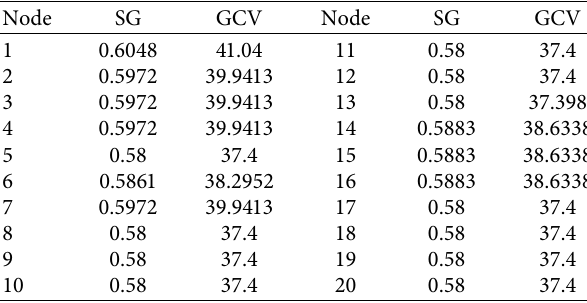
Figure 6: GCV at node